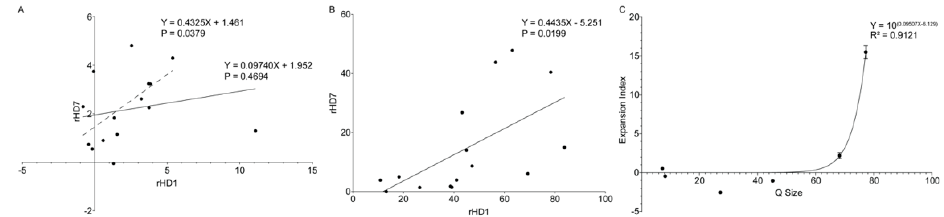
Figure 4. Correlations of expansion indexes between samples. ( A ) Expansion indexes from each tissue from rHD1 and rHD7 were plotted to show the tissue specificity of CAG expansion. A Spearman’s correlation showed a strong positive correlation between rHD1 and rHD7, which was statistically significant (R s (14) = 0.5341, p = 0.0261) when the rHD1 testis index was removed due to high expansion of CAG repeats in rHD1 testis. ( B ) The range of curve-fit data was plotted for corresponding tissue samples. A strong positive correlation was found between rHD1 and rHD7 (R s (14) = 0.5926, p = 0.0199). ( C ) When all expansion indexes of rHD1 and rHD7 are plotted against CAG repeat size (Q size), the expansion index follows a nonlinear regression model where the expansion index increases exponentially around 60Q.